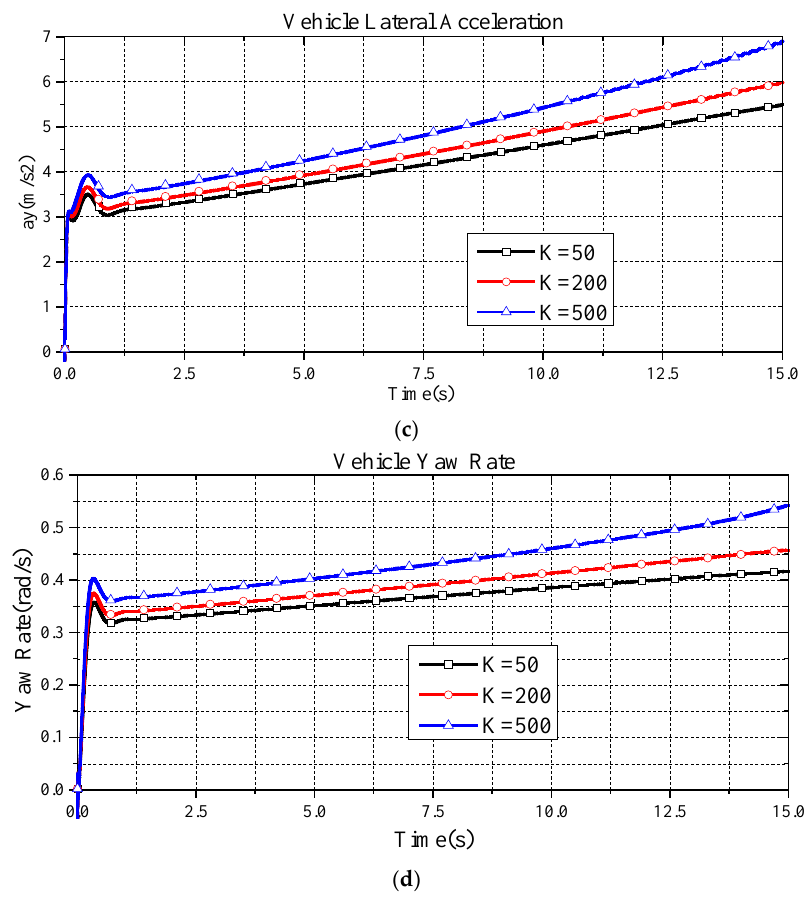
Figure 8. System performance. ( a ) Position of X coordinate; ( b ) Longitudinal acceleration; ( c ) Lateral acceleration; ( d ) Yaw rate.